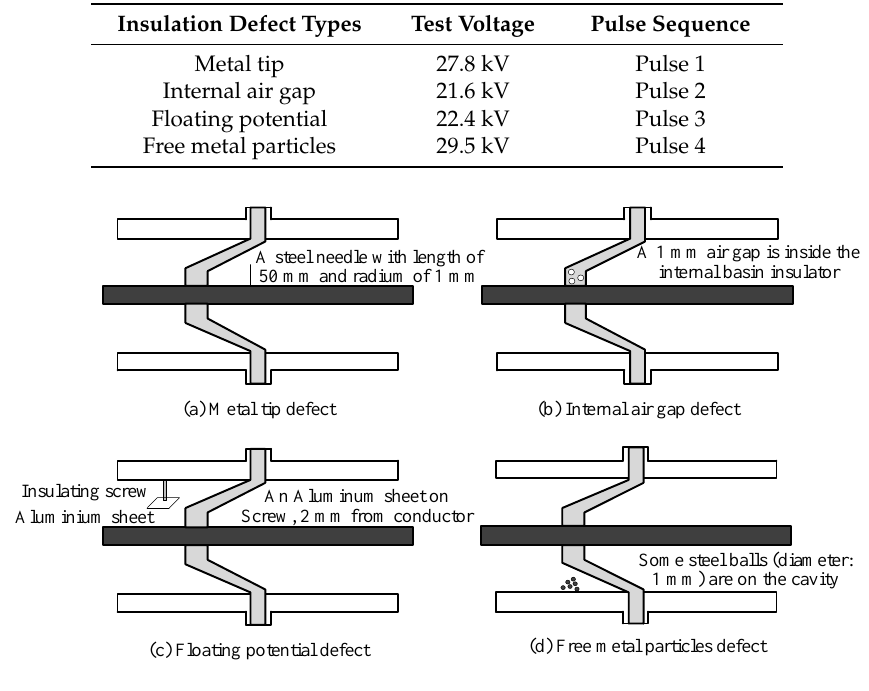
Figure 3. Simulation method of insulation defects.